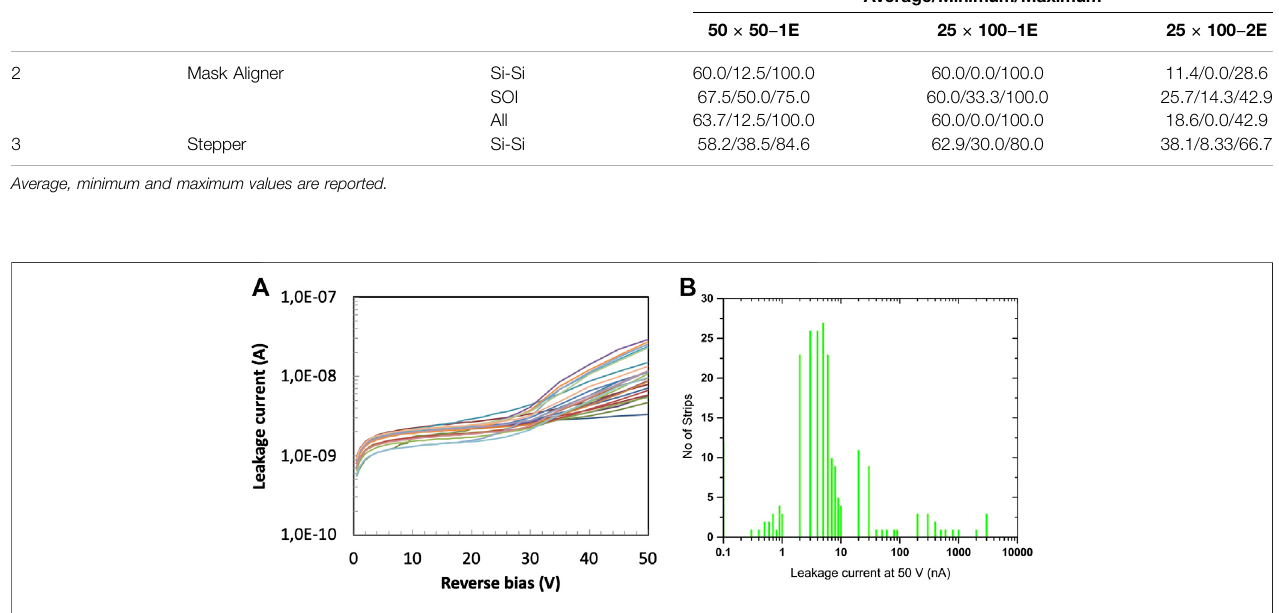
TABLE 2 | Summary of the wafer electrical yield for all RD53A-compatible 3D pixel sensors from batches 2 and 3. Batch # Lithography